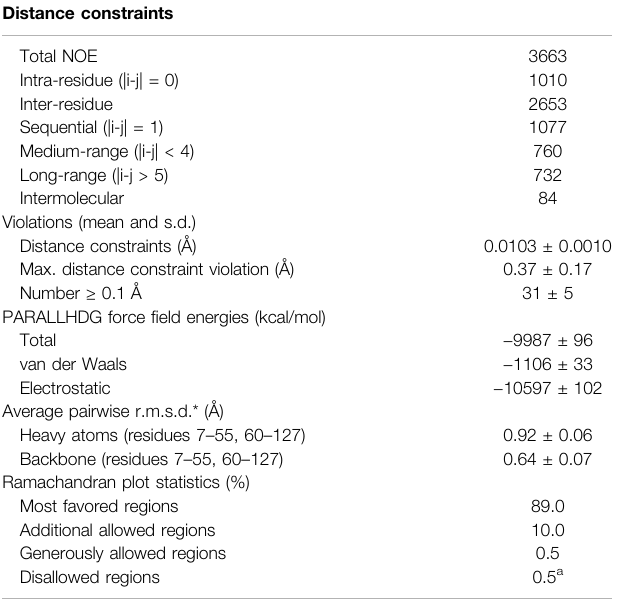
TABLE 1 | Input for the structure calculation and structural statistics for the energy-minimized NMR structure of TuSp NT at pH 5.5. Distance constraints